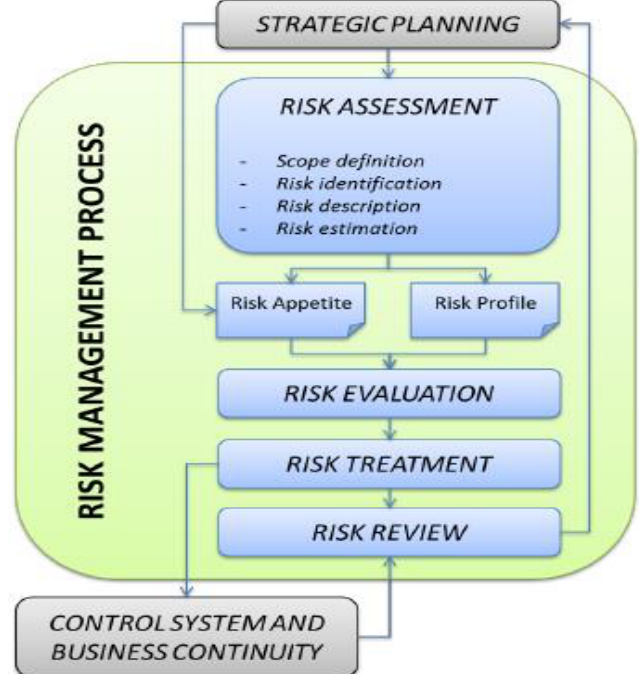
Figure 1. Risk assessment methodology.